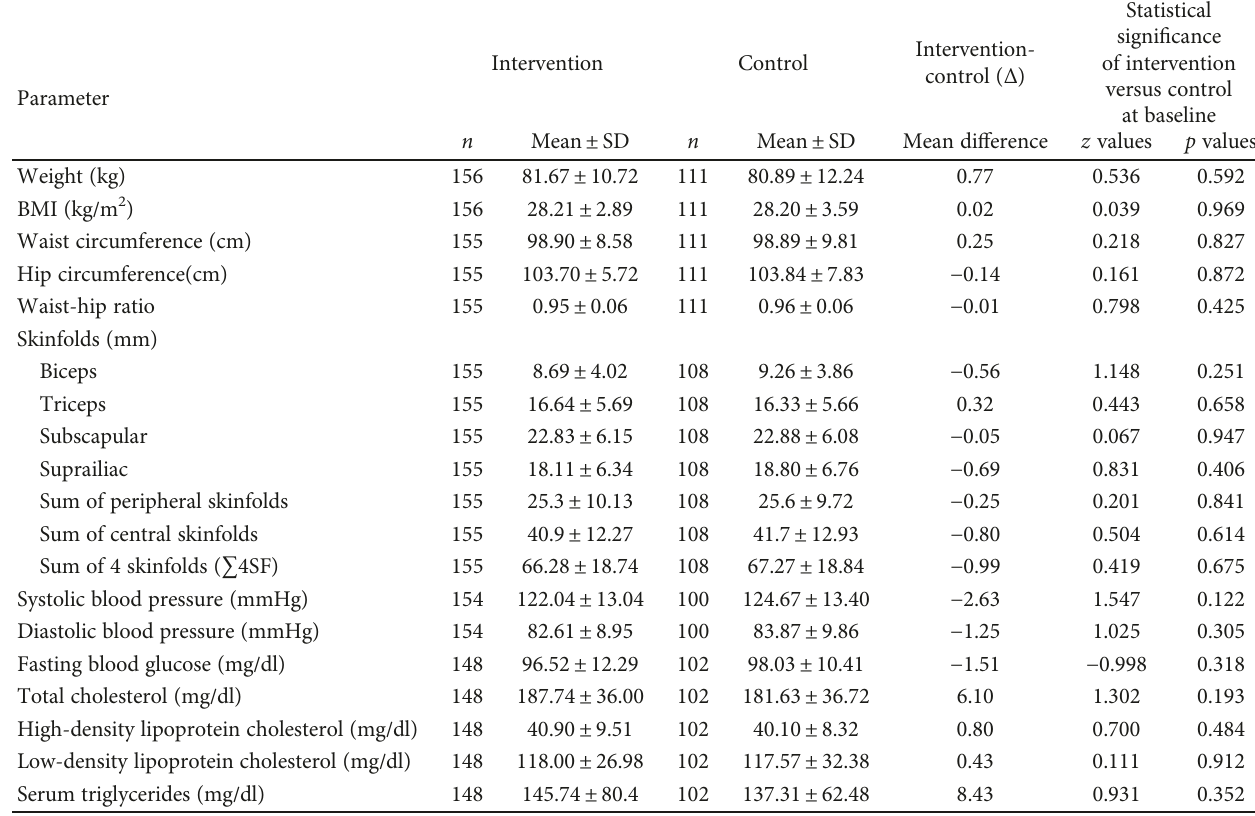
Table 3: Mean values of anthropometric, clinical, and biochemical pro fi les at